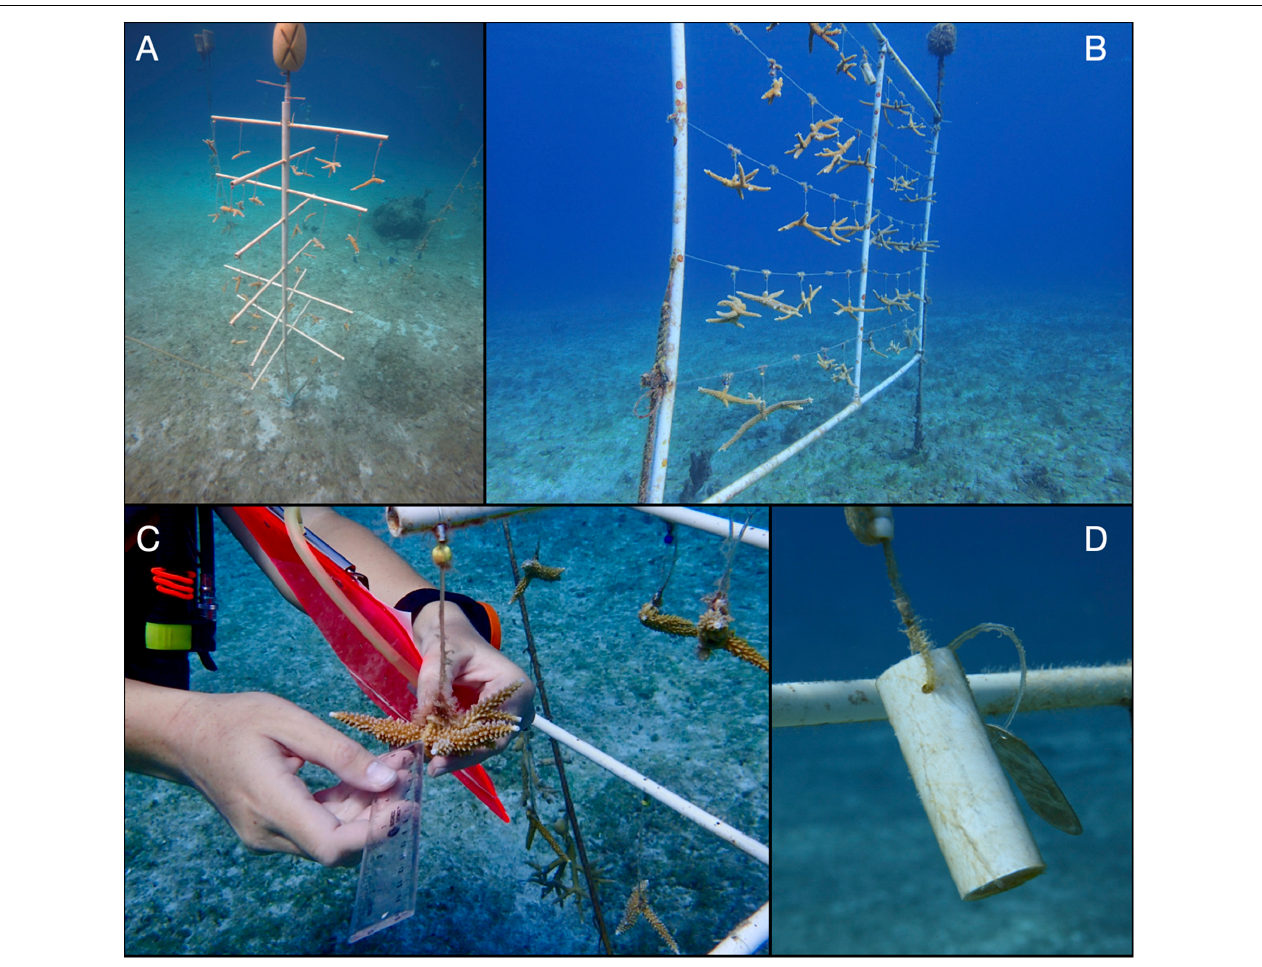
FIGURE 2 | Digital images of nurseries and data collection in this study. Two types of nurseries were used: (A) a tree that comprised a vertical column and nine horizontal PVC branches or a (B) frame that comprised PVC in a vertical rectangle with monofilament strung horizontally. (C) Total linear extensions of coral fragments measured by divers. Accumulation of biofouling was quantified on (D) 4-cm-long piece of PVC attached to the